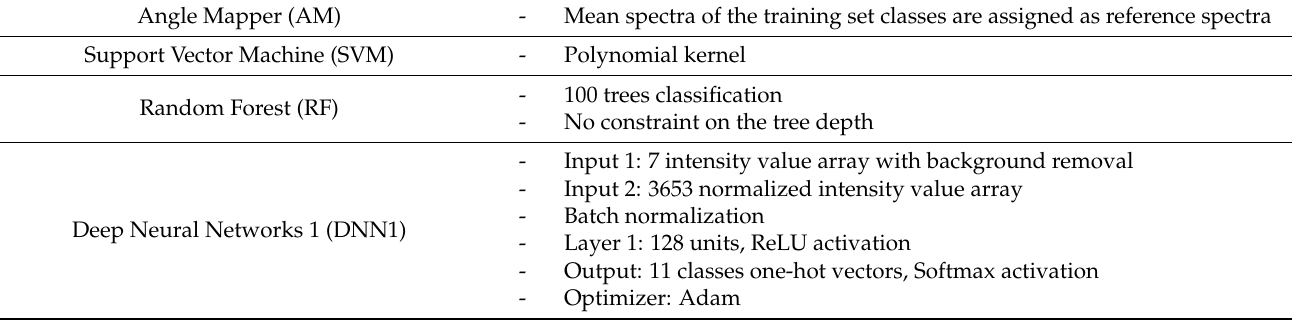
Table 4. Parameters of each machine learning and deep learning method. Angle Mapper (AM) - Mean spectra of the training set classes are assigned as reference spectra Support Vector Machine (SVM) - Polynomial